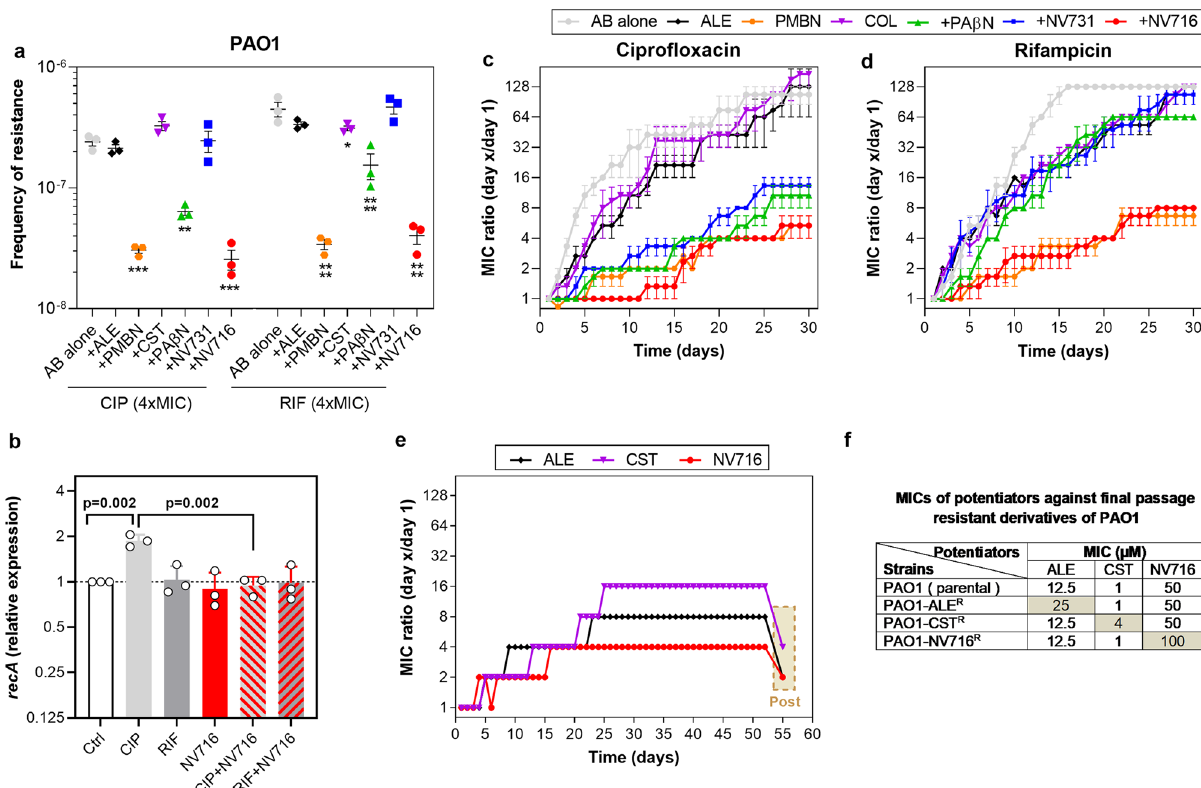
Fig. 5 Effect of potentiators on resistance selection in PAO1. a Frequency of resistance to cipro fl oxacin and rifampicin after 24 h of incubation with each antibiotic at 4 x MIC, in control conditions (antibiotic alone) or in the presence of alexidine (ALE, 2.5 µ M), polymyxin B nonapeptide (PMBN, 30 µ M), colistin (CST, 0.5 µ M), PA β N (38 µ M), NV731 and NV716 (2.5 µ M). All data are mean ± SEM (triplicates from three independent experiments). Statistical analysis: one-way ANOVA with Dunnett ’ s post-hoc test comparing each combination with antibiotic alone (* p < 0.05; ** p < 0.01; *** p < 0.001; **** p < 0.0001). b Quantitative real-time PCR of transcripts of the gene recA in the absence of or in the presence of antibiotics at ½ MIC, NV716 alone at 2.5 µ M or their combinations. Data, expressed in fold change vs . control samples, are means ± SEM of three independent experiments. Statistical analysis: